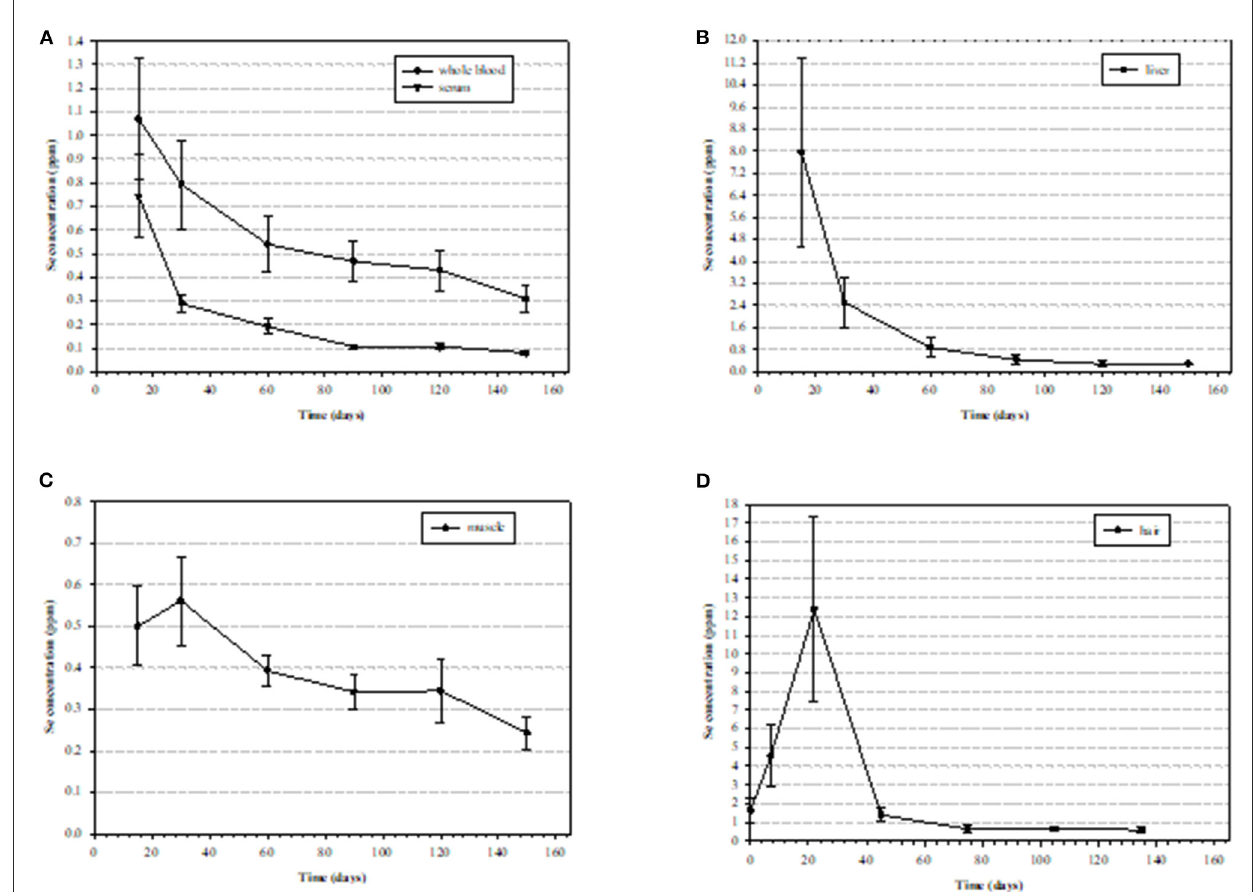
FIGURE7 Mean ( ± standard deviation [SD]) selenium (Se) concentrations (ppm) in tissues of nine steers starting at 15 days post exposure to high Se-containing western aster in (A) whole blood with an elimination half-liver (E 1 / 2 ) of 115.6 ± 25.1 days and serum with and E 1 / 2 of 40.5 ± 8.2 days), (B) liver (wet weight) with an E 1 / 2 of 38.2 ± 5.0 days, (C) semitendinosus muscle E 1 / 2 with an E 1 / 2 of 98.5 ± 19.1 days, (D) hair (dry weight)